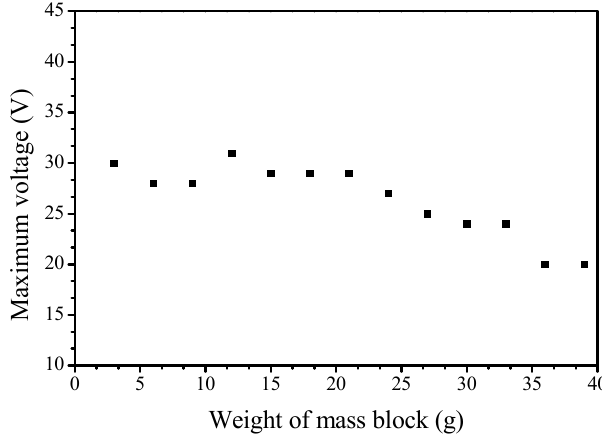
Figure 14. Weight of mass versus maximum voltage in simply supported beam fixation mode.